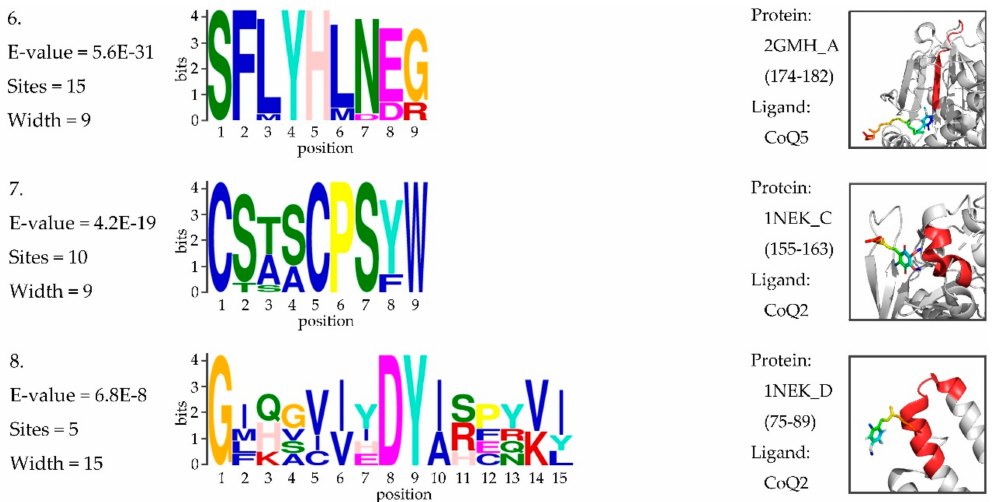
Figure 4. Sequence logos of the motif within the ubiquinone-binding domains. The threshold of the E-value is 0.05. “Sites” represents the number of sites contributing to the construction of the motif. “Width” represents the width of the motif. The 3D visualization on the right is an example of the corresponding motif. “Protein” represents the PDB ID_Chain (domain). “Ligand”